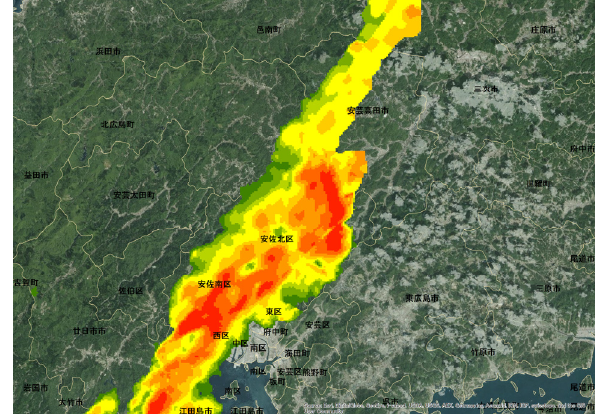
Figure 5. The flow of processing of the conversion of the GIS data of the X-band MP radar rainfall data is shown.